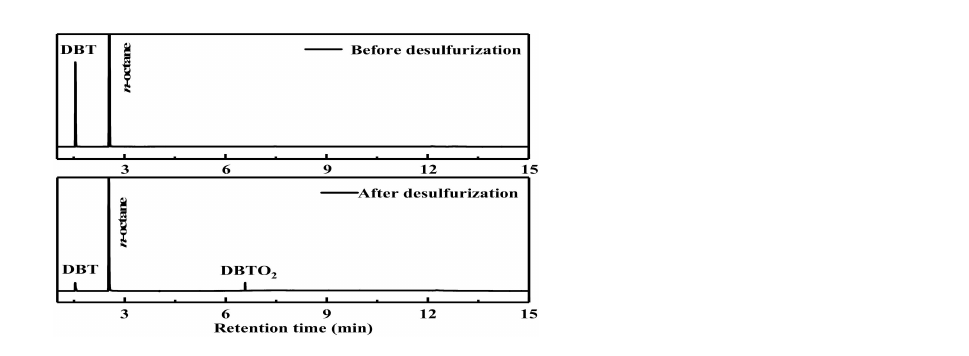
Figure 10. GC-FID of the model oil containing DBT before and after desulfurization in the proposed system.